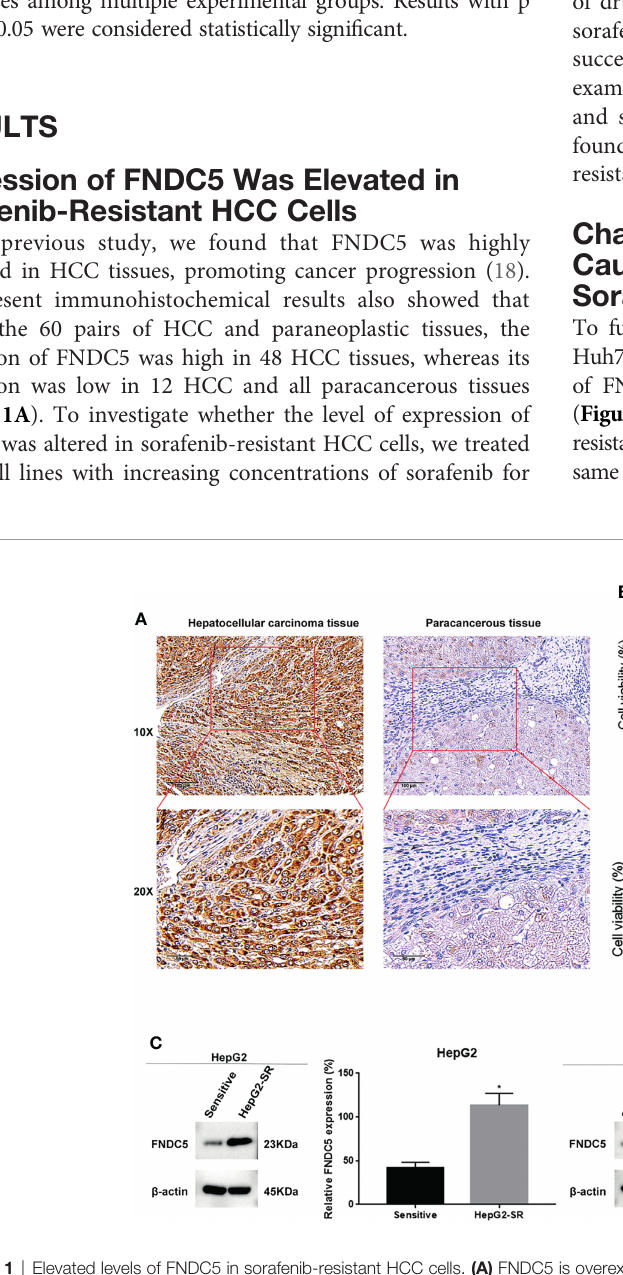
( Figure 1B ). Following treatment of HCC cells with different concentrations of sorafenib for 24 h, we found that the viability sorafenib-sensitive HCC cells ( Figure 1B ). After con fi rming the examined the expression of FNDC5 in HCC sorafenib-resistant and sorafenib-sensitive HCC cells using western blotting. We found that the expression of FNDC5 was signi fi cantly higher in resistant cells than in sorafenib-sensitive HCC cells ( Figure 1C ).